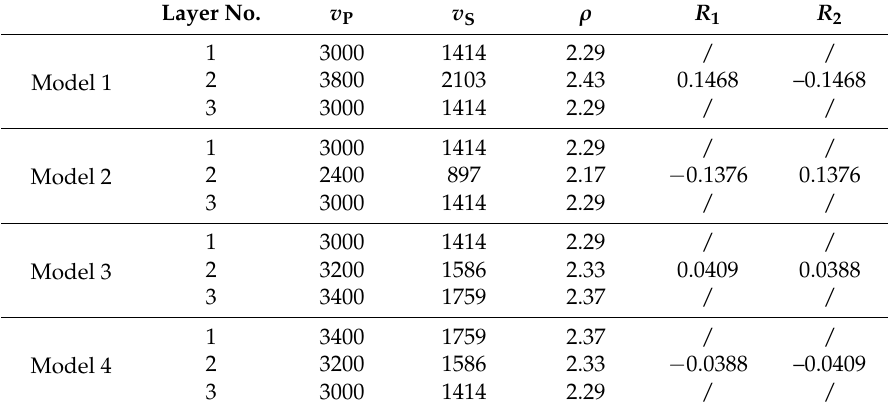
Table 1. Rock properties of thin-bed models, units of velocities and densities are m/s and g/cm 3 ,